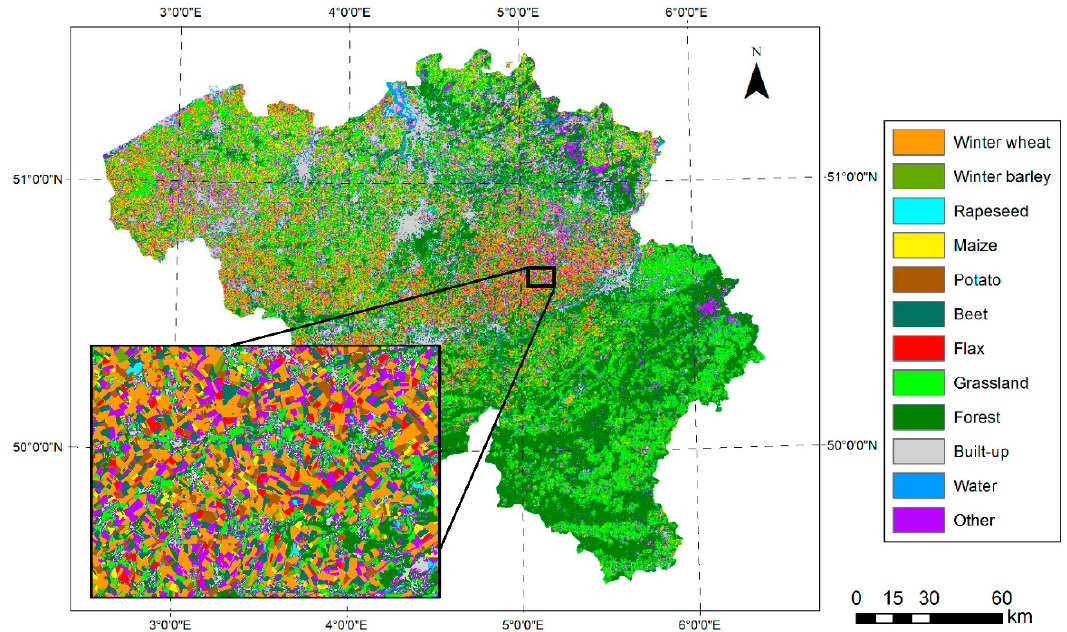
Figure 5. Final classification result by the end of August 2017 based on Sentinel-1 and -2 inputs. Inset shows a detailed view on the classification results in a highly diverse arable landscape.